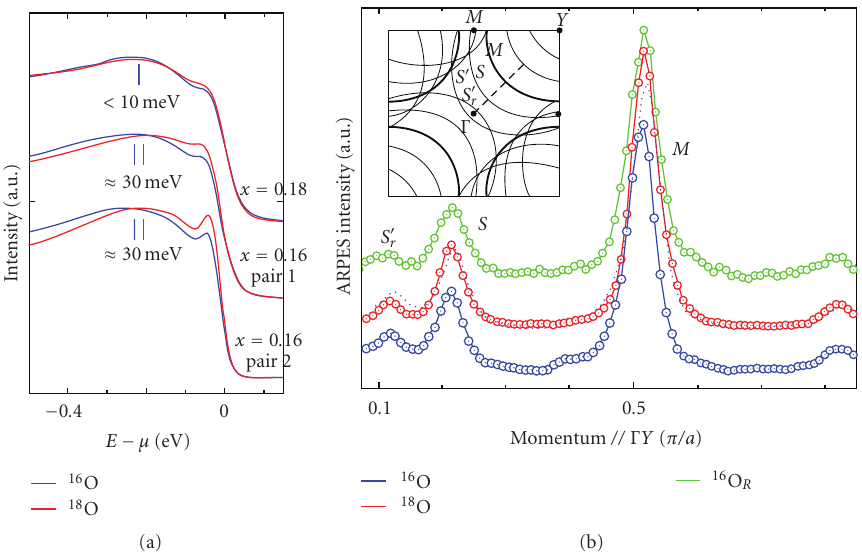
Figure 11: (a) Angle integrated photoemission data from two sets of data at optimal doping ( x = 0.16) and one set at a slight over-doping ( x = 0.18). Data has been normalized to the area under curves for energies 0.5 and above. (b) MDCs taken near E F along the Γ - Y nodal direction as seen from the inset. The peaks correspond to the intersection of the cut with the main Fermi surface band ( M ) as well as first- ). Overlaid on top of the red curve is a thin grey line representing the order superstructure reflections ( S ) and a second-order reflection (S (cid:6) r 16 O curve shifted to model a 0.01 change in doping for comparison. Panel (a) is from